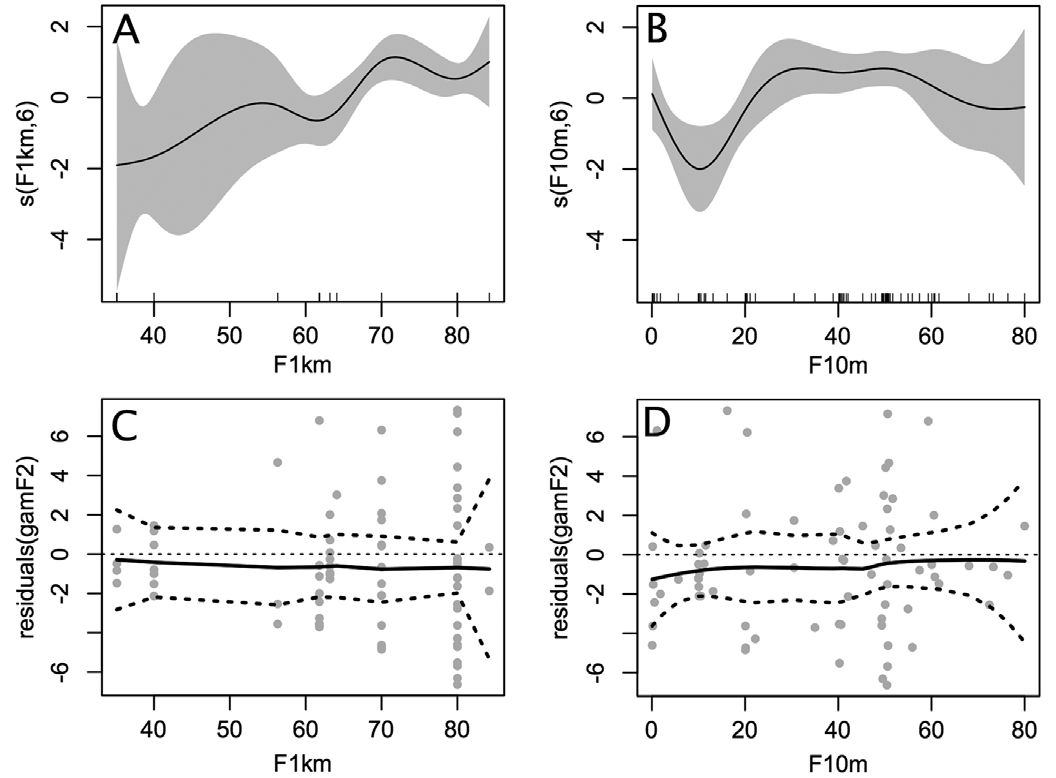
Fig. 4. – Generalized additive model (GAM) validation plots. Smoothing functions for the explanatory variables F1 km (A) and F10 m (B). Standardized residuals for the optimal GAM plotted against observations for each explanatory variable (C, D), with LOESS fit predictions for mean (span 0.65; solid black line) and 95% confidence intervals (dashed black lines) superimposed on the observed data (grey dots), showing no residual